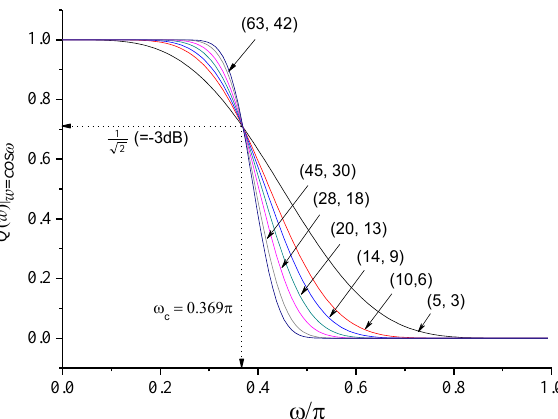
Figure 7. Comparison of three design methods: ( 𝜔 𝑐 = 0.369𝜋 ) for ( a ) 𝑁 = 20 and ( b ) 𝑁 = 45 .